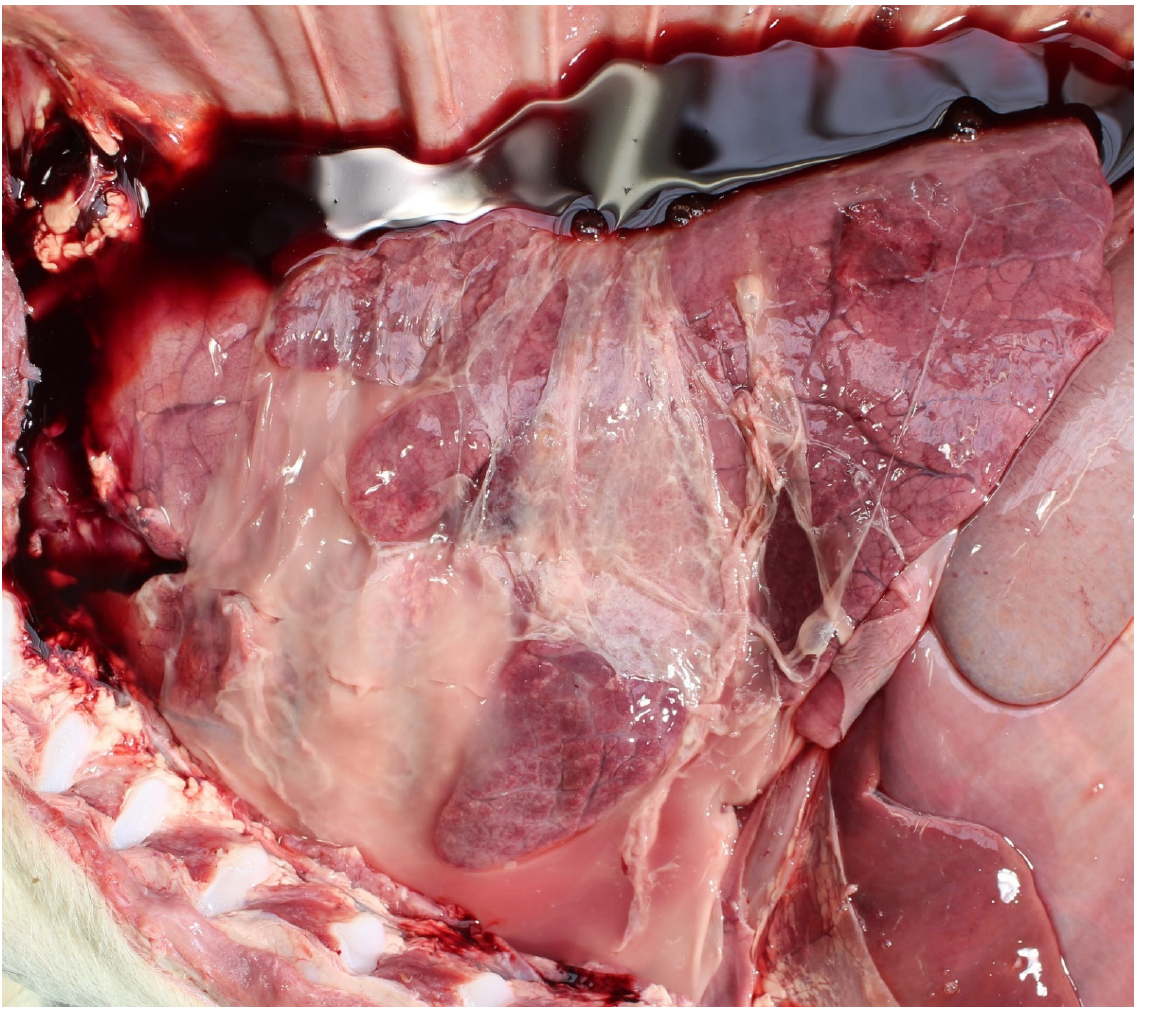
Figure 5. Extensive pleuropneumonia a foetus infected with Trueperella pyogenes.